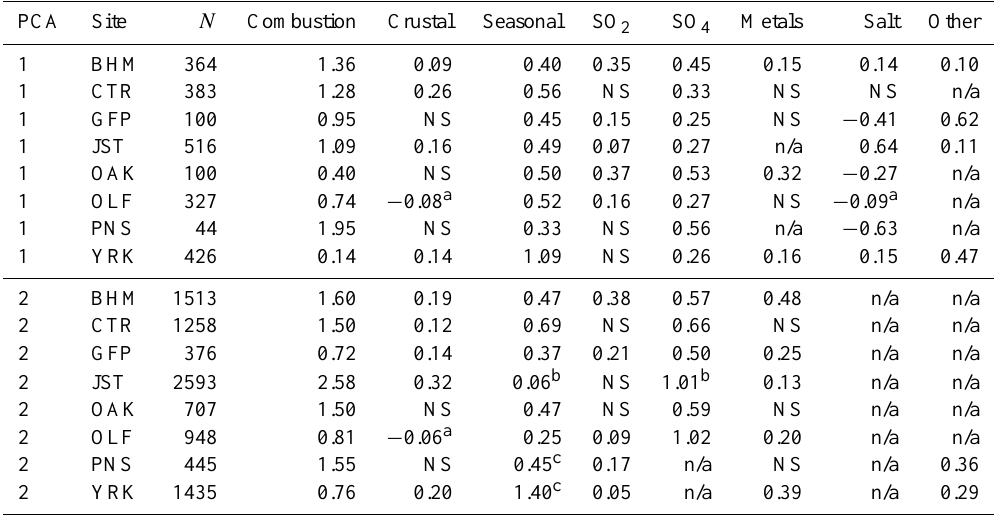
Table 3. Mean OC concentrations associated with components identified by PCA1 (2008–2013) and PCA2 (1999–2013). NS is not statisti- cally significant, n/a is not applicable (component not present in PCA). Units are µgm − 3 . Standard errors of the means ranged from